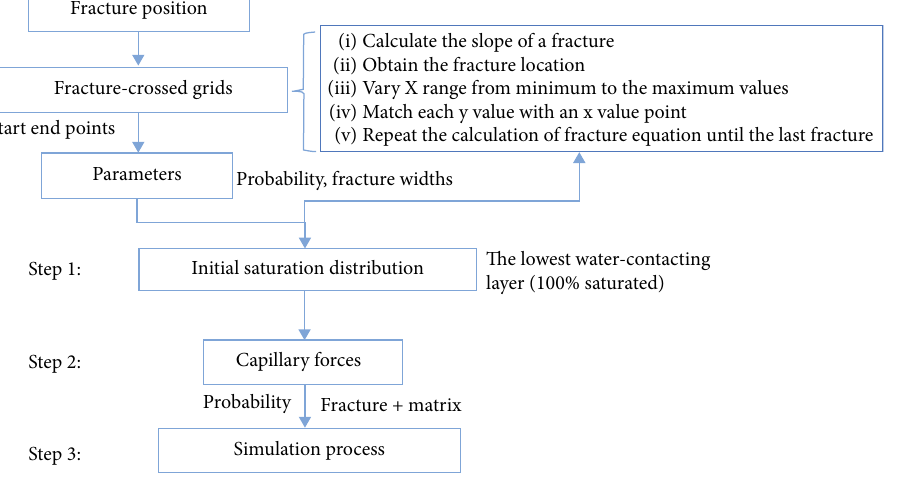
Figure 4: Work fl ow of 2D simulation model. Table 1: Parameters used in the 2D simulation